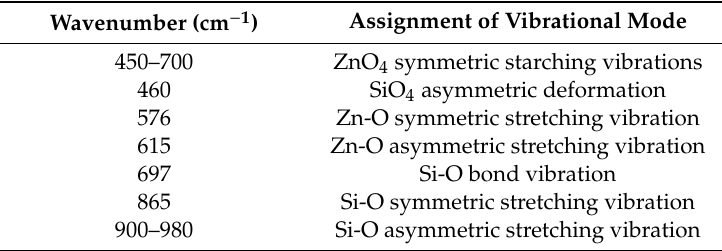
Figure 4. FTIR spectra of the zinc silicate glass and glass-ceramics that were heat treated at various sintering temperatures. Table 2. FTIR assignment bands for the zinc silicate glass and glass ceramic after sintering [8].